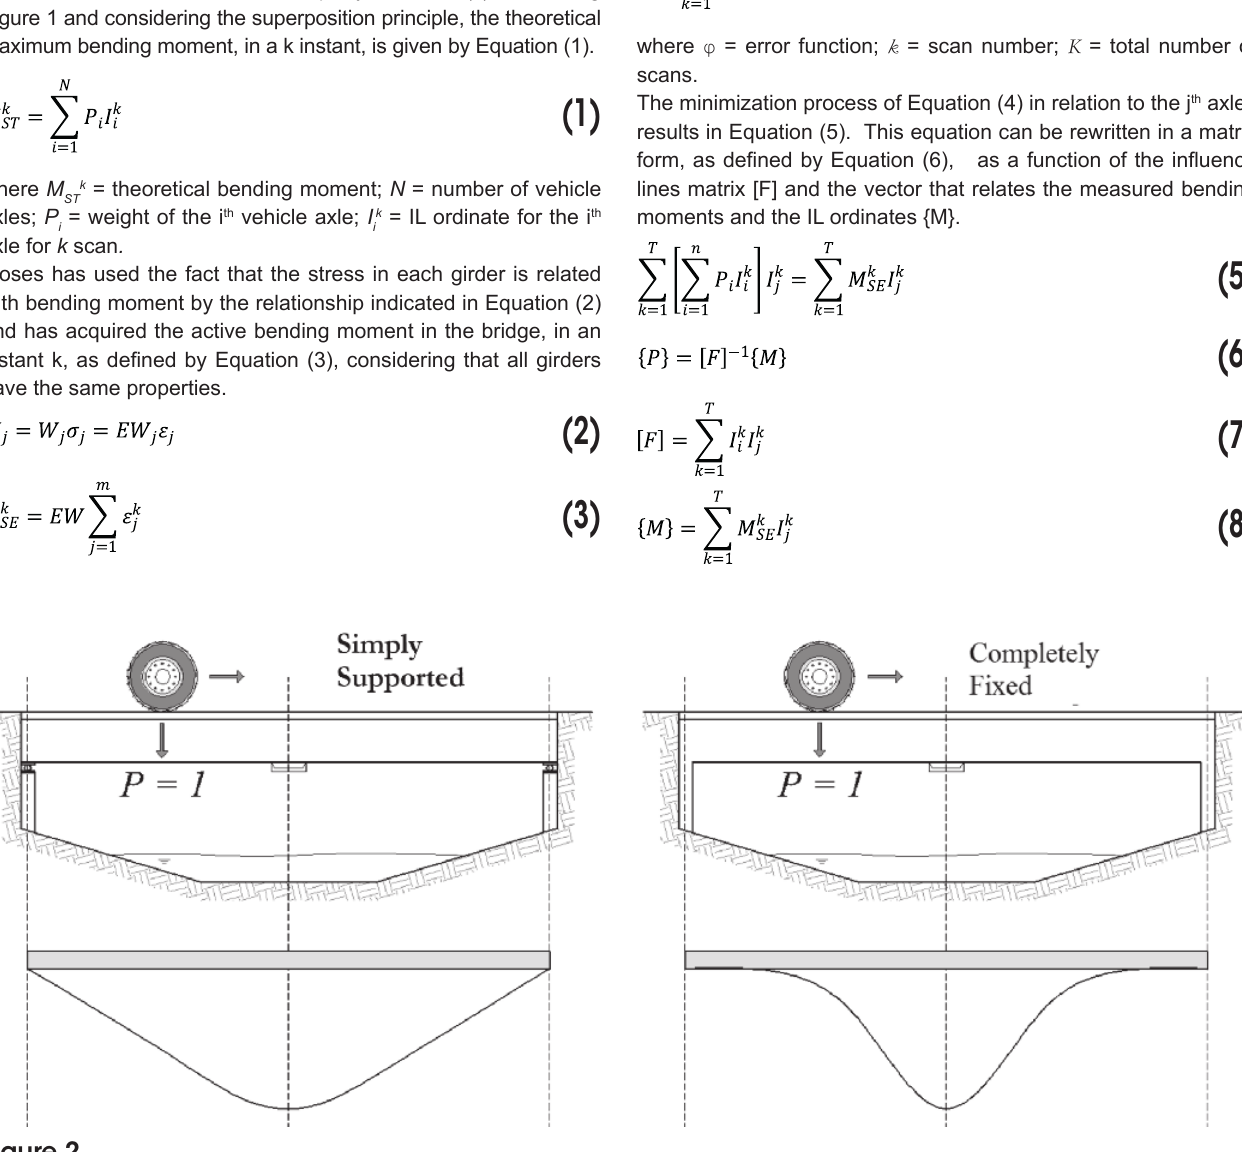
Figure 2 Influence line for bending moments at midspan of bridges simply supported and completely